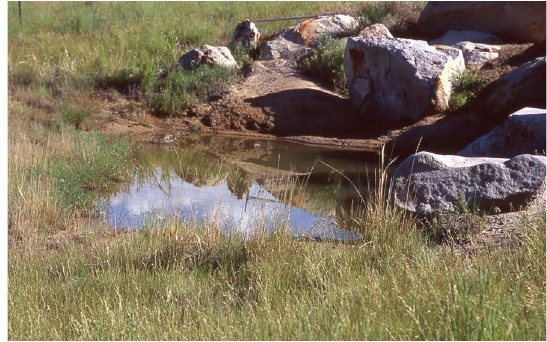
Fig. 15 Surface boulders and discharge containment area (2010)